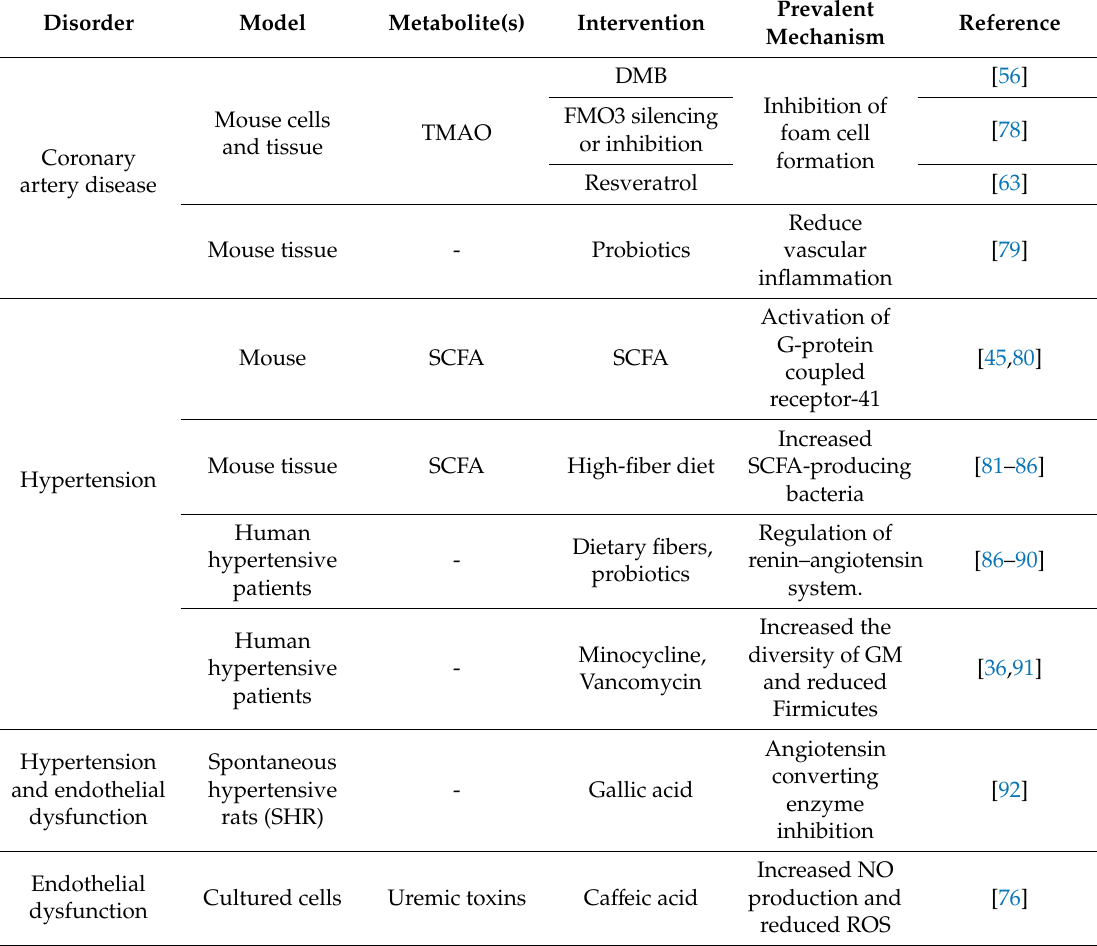
Table 1. Studies to control intestinal gut metabolites useful in endothelial dysfunction related cardiovascular